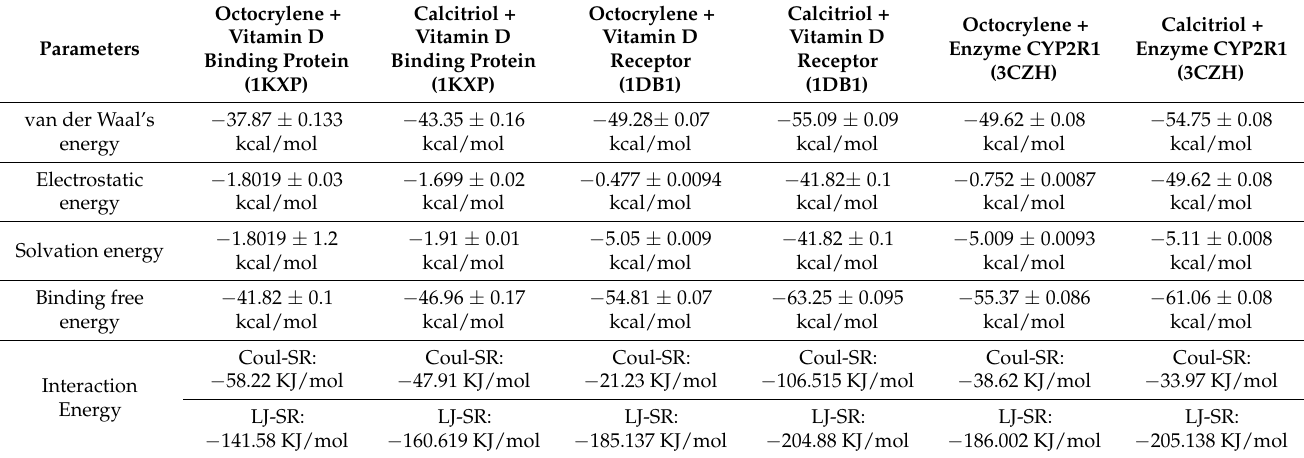
Table 3. Molecular mechanics Poisson–Boltzmann surface area (MM-PBSA) and interaction